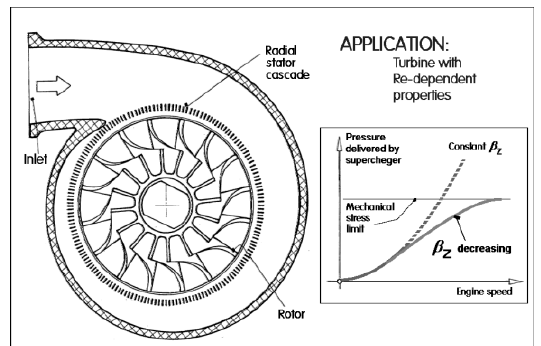
Another application in a radial turbine. The decreasing inclination  Z of the stator exit flow prevents surpassing the pressure limit above which would be endangered engine